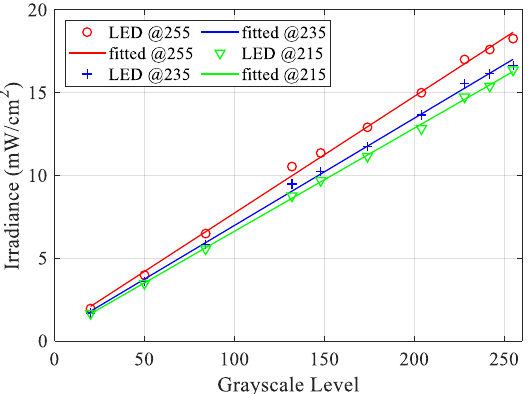
Figure 8. Relation between the grayscale level of the pixels and irradiance level. Table 2. Measured irradiance values across the build area (mW/cm 2 ).